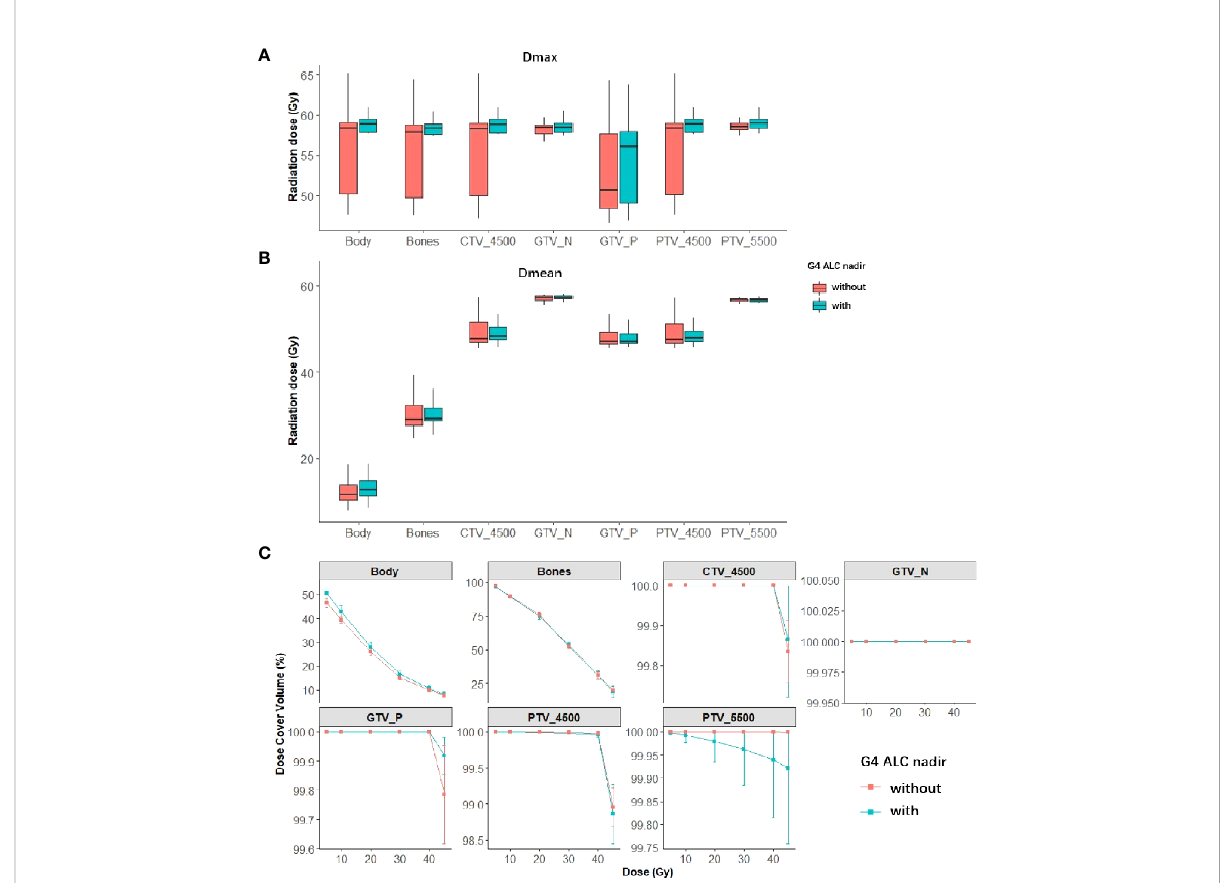
FIGURE 3 Summary of dose – volume histogram (DVH) metrics of both tumor targets and organs at risk (OARs) in patients with or without G4 ALC nadir (red is the summary of DVH metrics in patients without G4 ALC nadir; green is the summary of DVH metrics in patients with G4 ALC nadir). Panels (A, B) show the median (95%CI) of Dmax and Dmean of both tumor targets and OARs in patients with or without G4 ALC nadir. Panel (C) shows the relative volume (in percentage) covered by different dose levels of both tumor targets and OARs in patients with or without G4 ALC